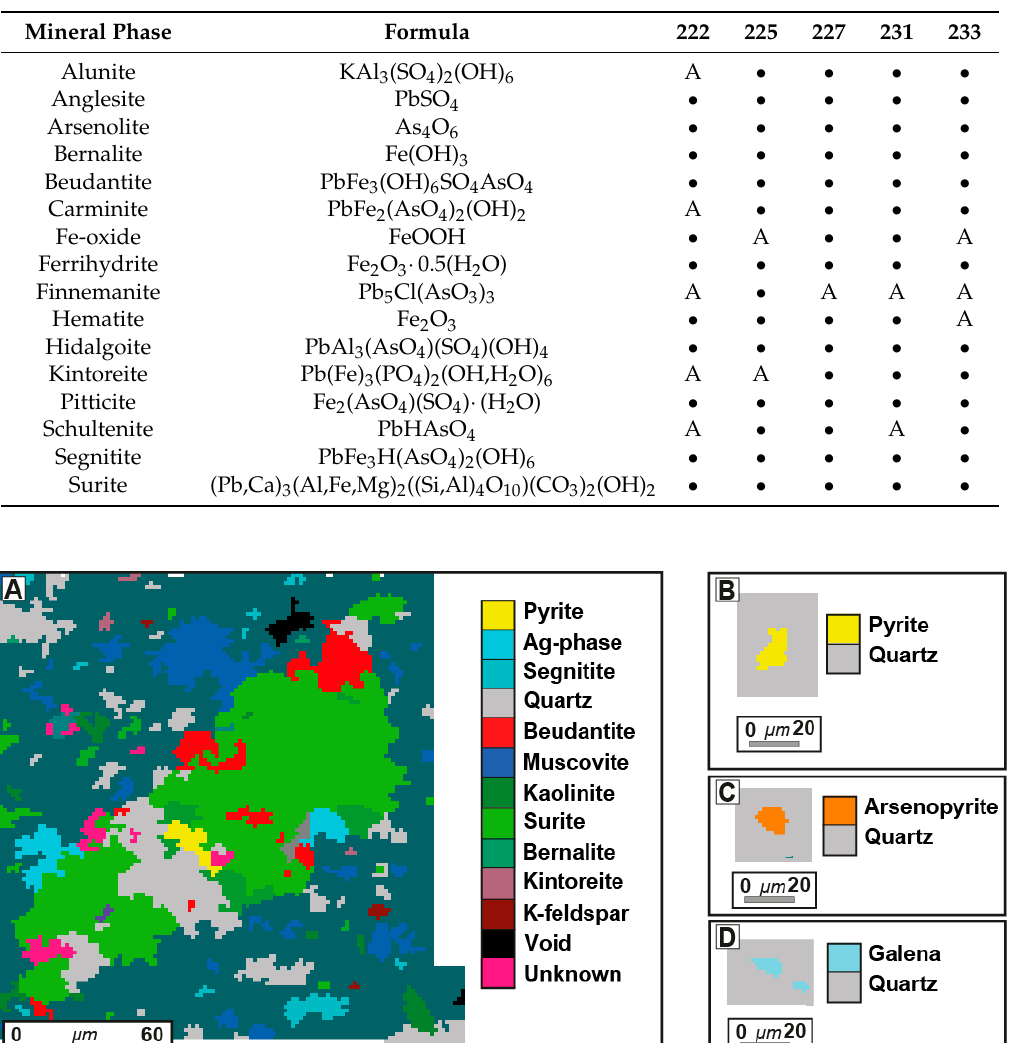
Table 1. Secondary mineral phases identified by mineral liberation analysis ( ‚ —present; A—absent).